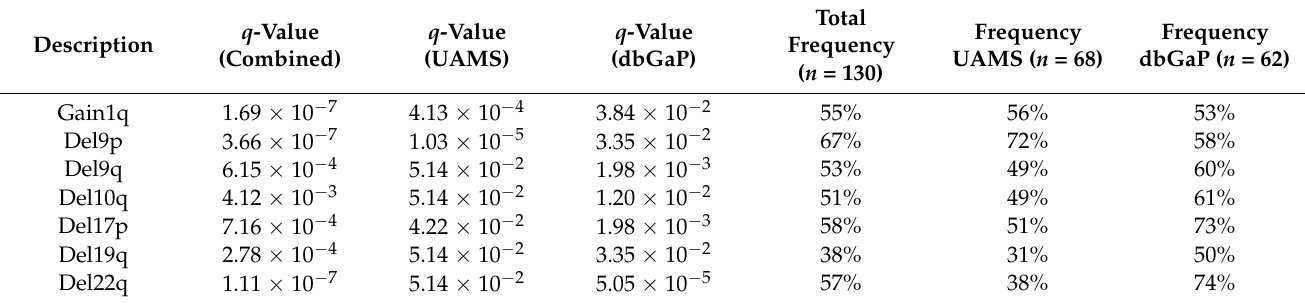
Figure 3. ( A ): Copy number events detected in BM. Red denotes gain and blue loss, with broad events coloring the entire arm and focal events represented using colored bars at the site of the events. Only affected chromosomes are shown. Candidate genes for focal events are labelled and events only identified in the dbGaP data set are labelled with an asterisk. Detailed tabulation is shown in Tables 2 and 3. ( B ): Correlation plot of copy number events. Positive correlations with significant p -values after Bonferroni multiple testing correction ( p < 1.7 × 10 − 4 ) were found for multiple pairs of features and were not restricted to specific subtypes. Pearson correlation is labelled with a color scheme from negative (red) to positive (blue) and larger colored squares represent smaller p -values. Table 2. Broad focal copy number events in BM.